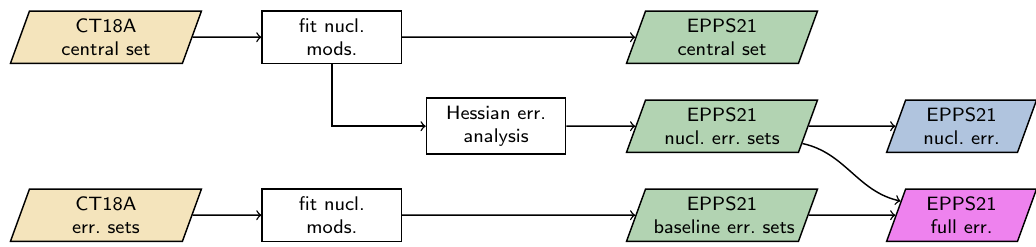
Figure 1: The error analysis flow in the EPPS21 global